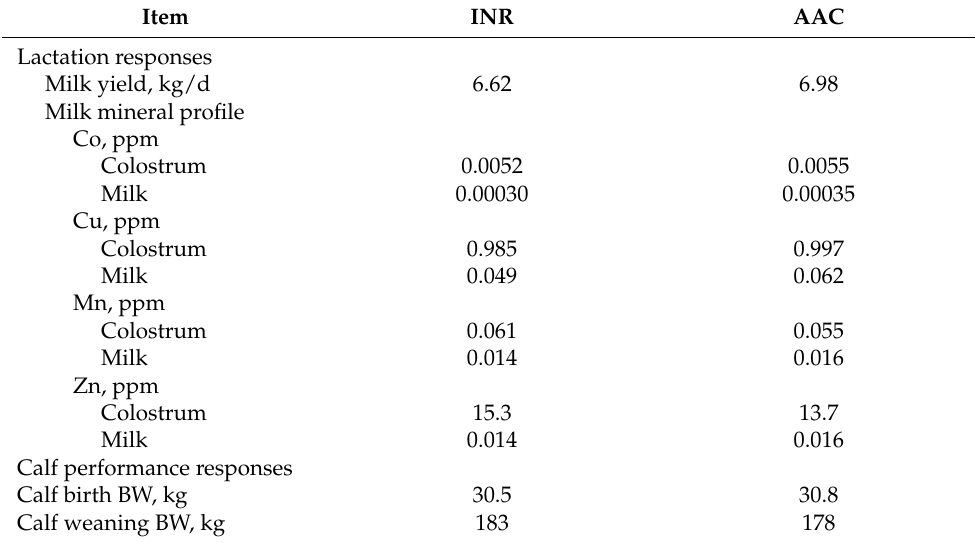
Table 4. Lactation responses of beef cows that received diets containing supplemental sulfate sources of Co, Cu, Mn, and Zn (INR) or organic-complexed Co, Cu, Mn, and Zn (AAC) during gestation, and performances responses of their offspring until weaning 1